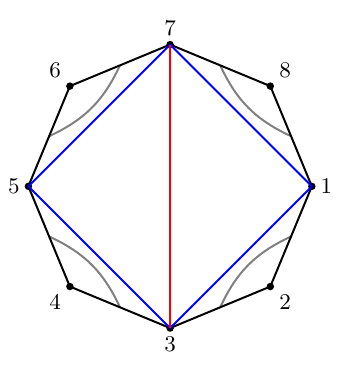
Figure 7 . An example of the basis Y for α = [(1 , 2) , (3 , 4) , (5 , 6) , (7 , 8)] . The gray curves are flavor lines. The blue diagonals correspond to { X 2 i − 1 , 2 i +1 } , which gives the partial triangulation that isolates the maximal adj sub-amplitude. The red diagonals correspond to { X 3 , 2 j +1 } , which gives the triangulation of the resultant sub-polygon associated with the maximal adj